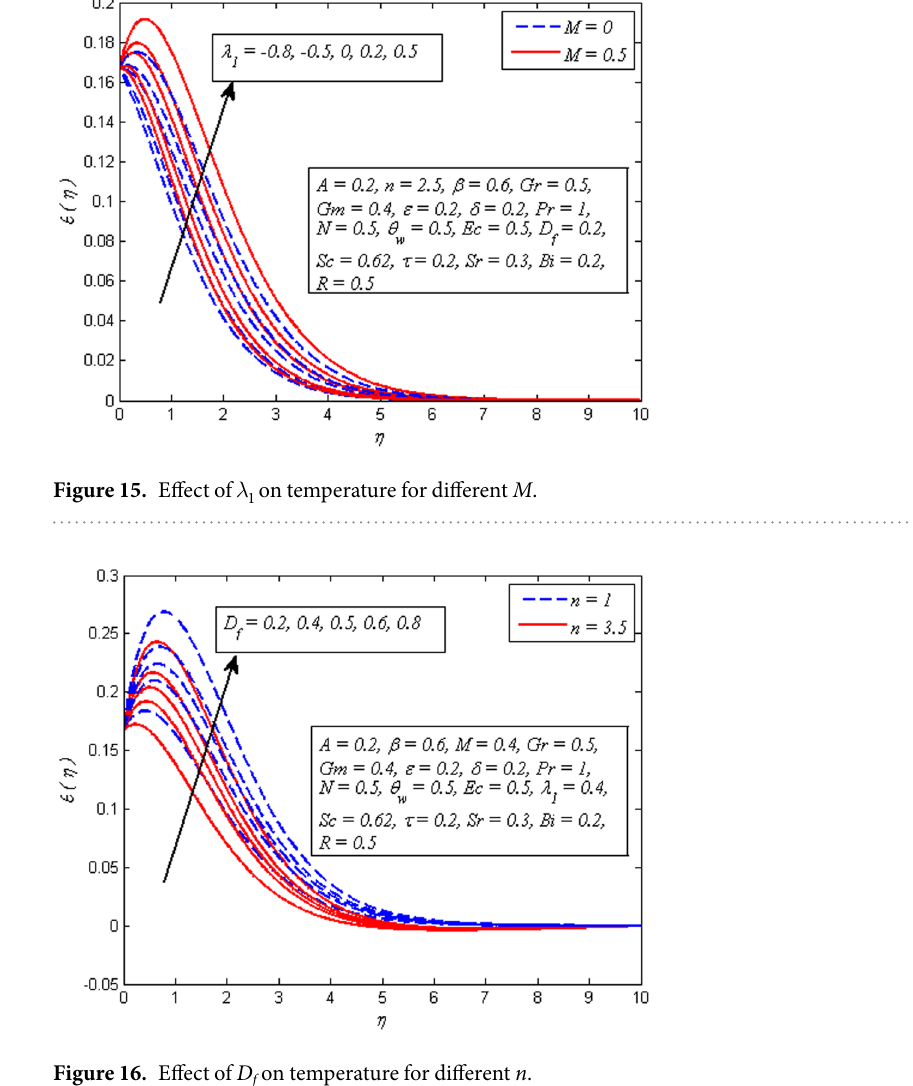
Figure 16. Effect of D f on temperature for different n .